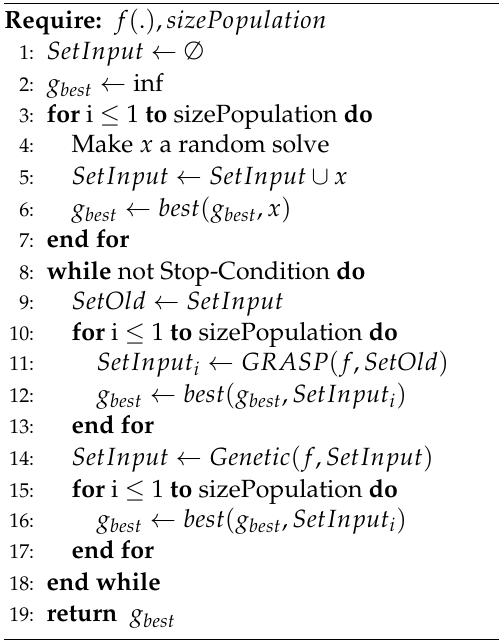
Algorithm 2 MAGMA: cooperative